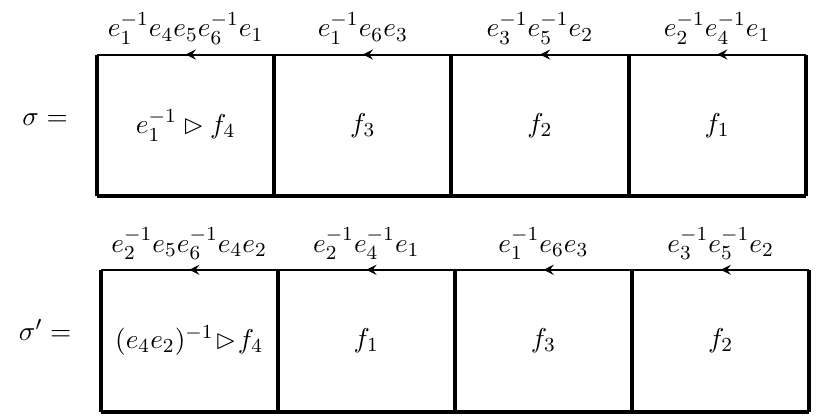
Figure 11 . Graphical representation of two ways to construct a generator of π 2 ( X 2 , X 1 ; ∗ ) for the tetrahedron from figure 10: σ = ( e − 1 σ = σ 0